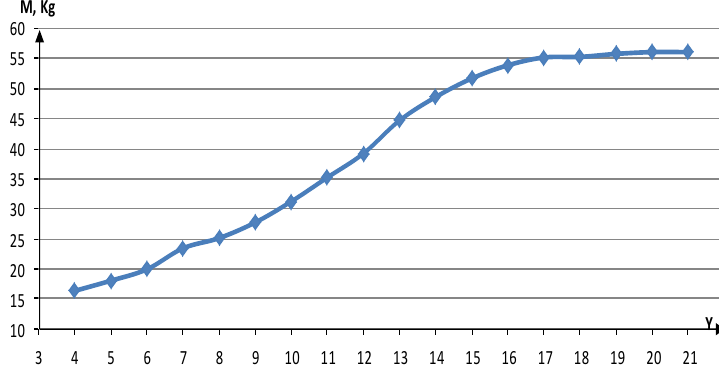
Fig. 2. . Dynamic of M, kg (weight) indicators’ changes from Y (age, years)